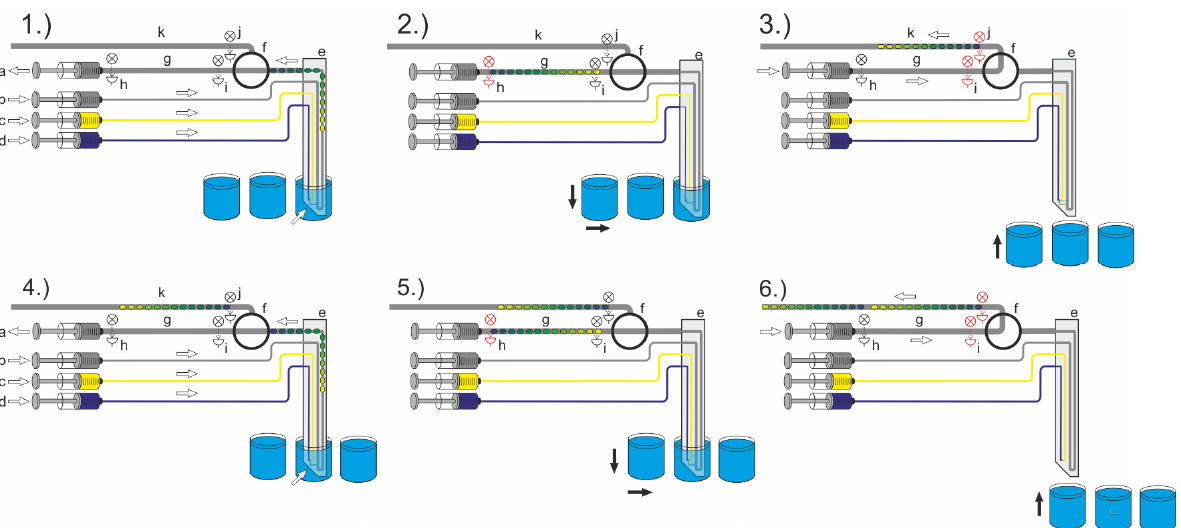
Figure 6. Scheme of the overall droplet sequence aspiration system workflow. (The process step order (1.–6.) is discussed in the text).